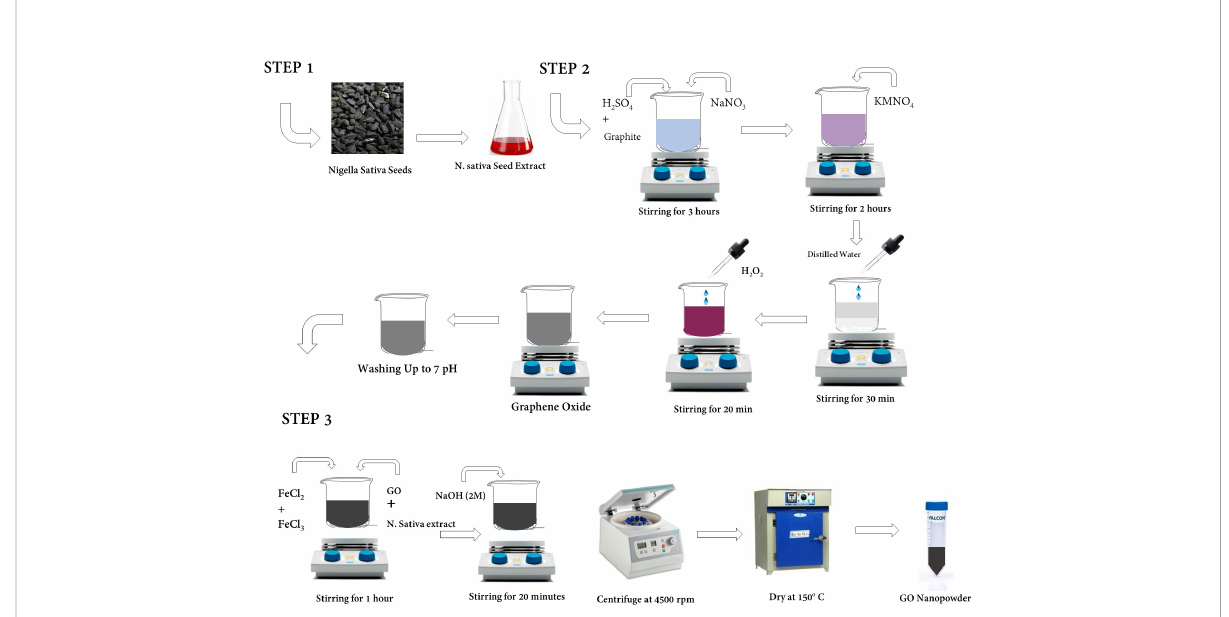
FIGURE 1 Schematic representation of the synthesis of graphene oxide